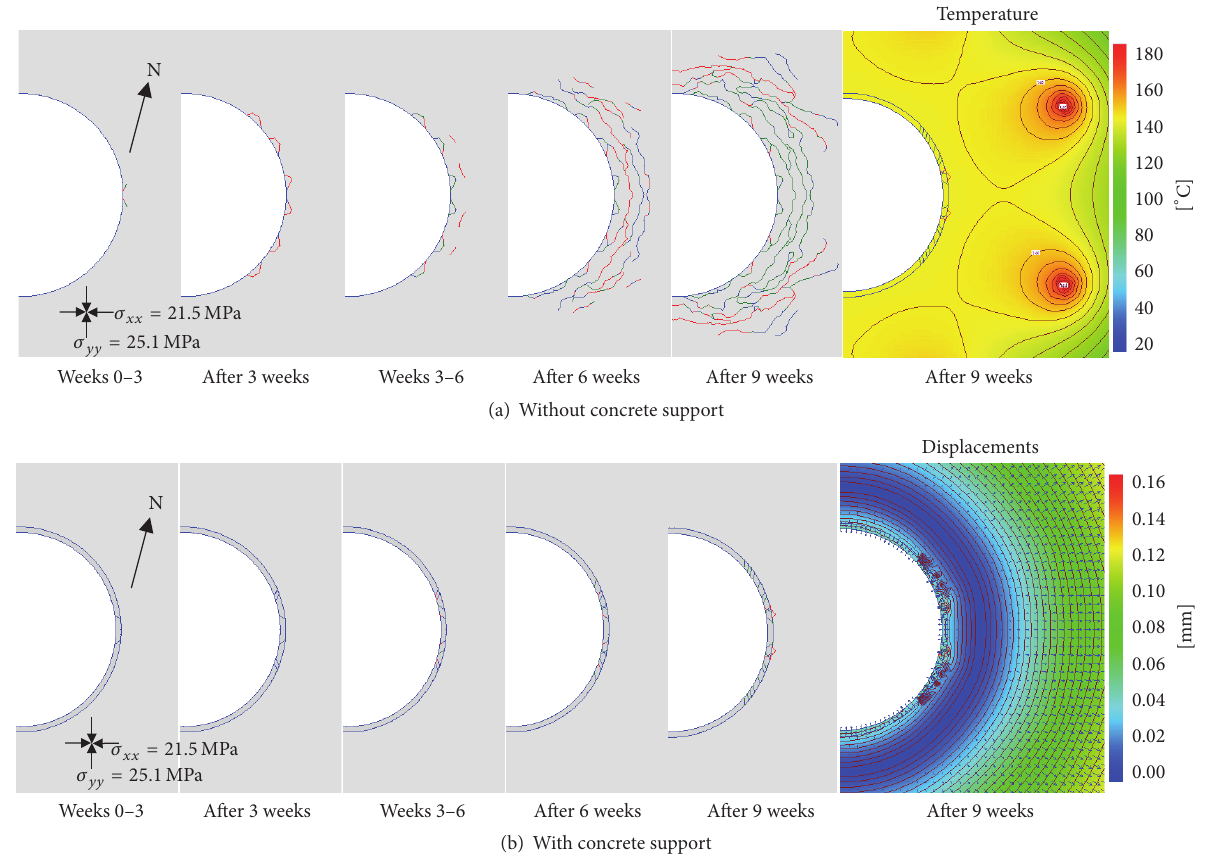
Figure 17: Predicted development of fracture initiation and propagation during nine weeks of heating for EDZ and VT1 stress interpretation (a) without concrete support (upper row) and (b) with concrete support (lower down). The temperature distribution is shown in top right figure and the displacement distribution and displacement vectors after nine weeks are shown on the bottom right. The temperatures and displacements are similar for both stress interpretations. The fractures are color-coded red green for tension (mode I), red for shear (mode II), and blue for boundary